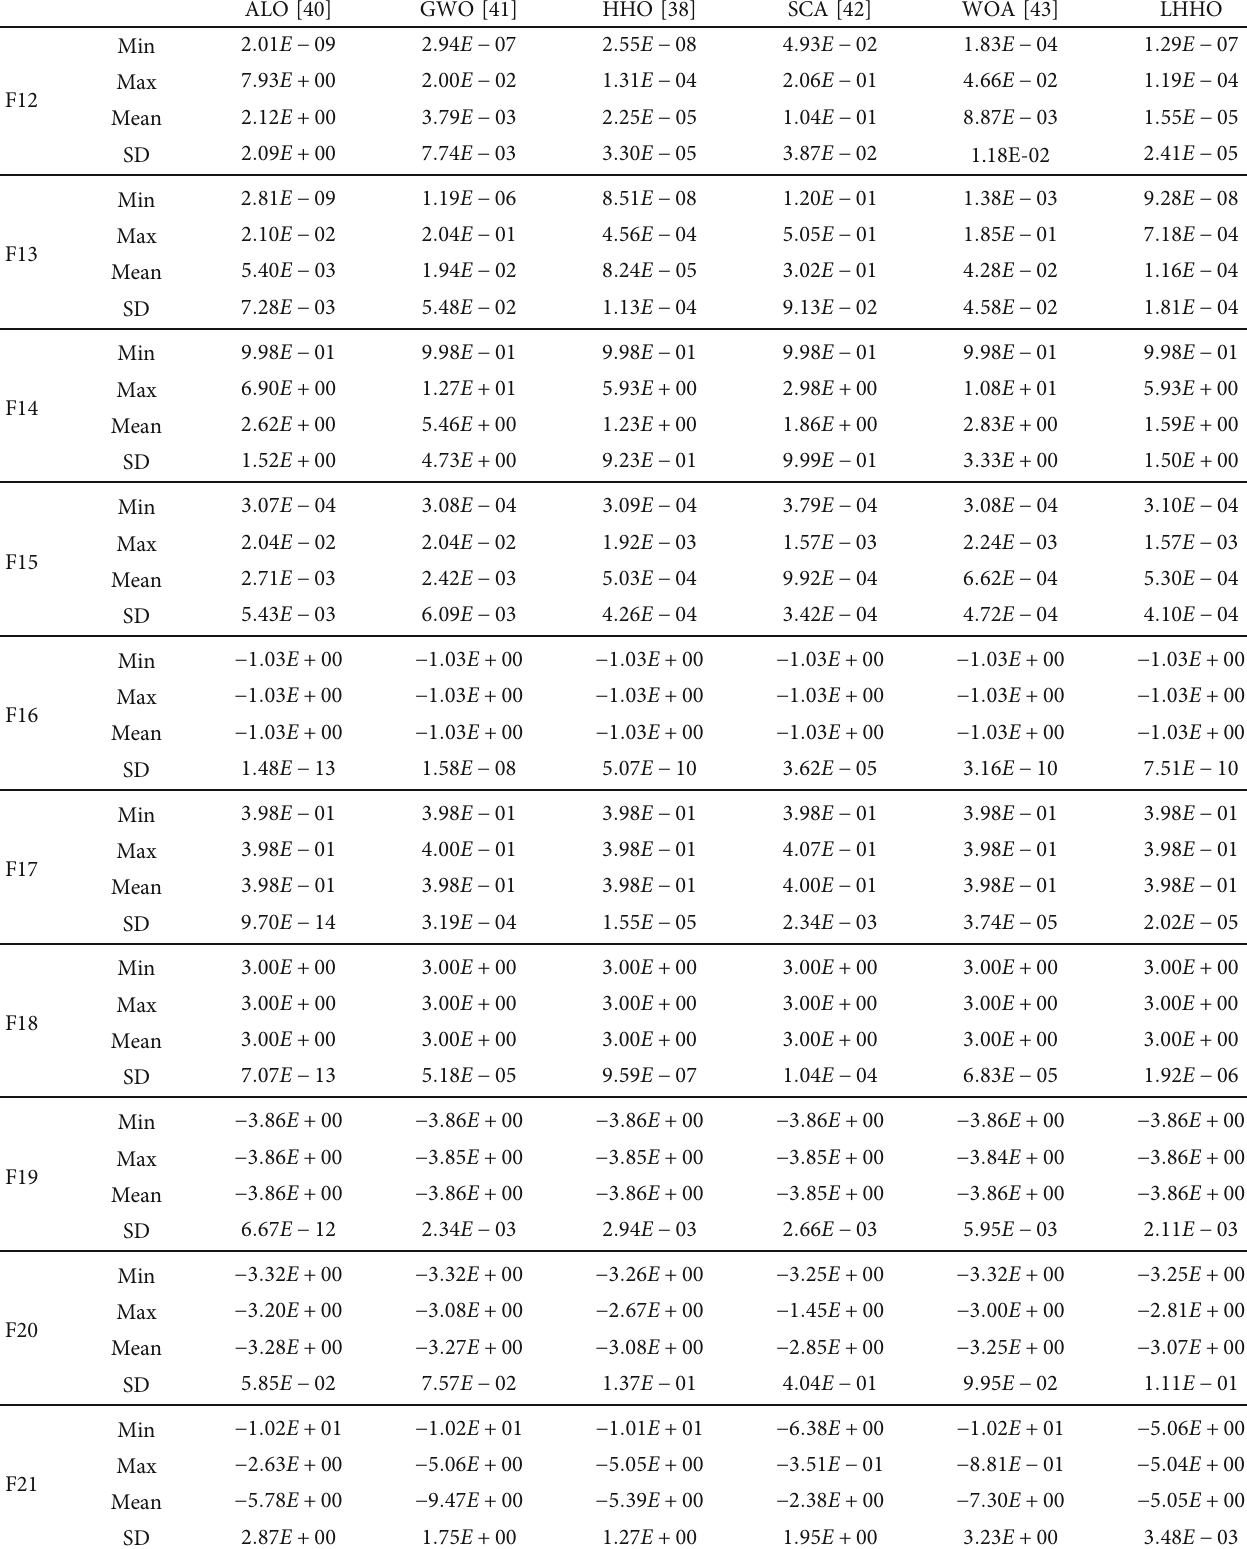
Table 3: Results of conventional benchmark functions